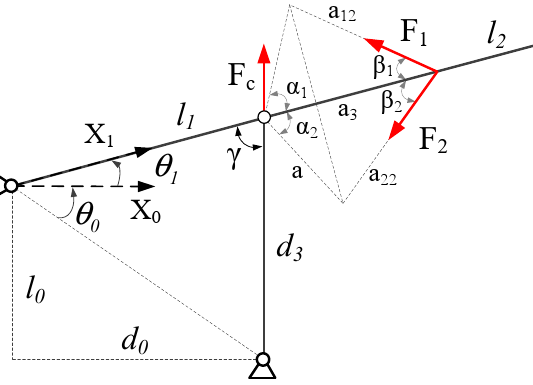
Figure 3. The forces acting on the two-link manipulator.